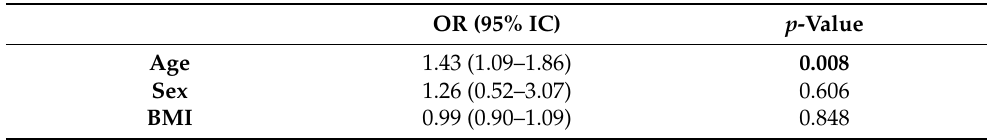
Table 3. Multivariate logistic regression to analyze high-quality chest compression as the dependent variable adjusted for age, sex and body mass